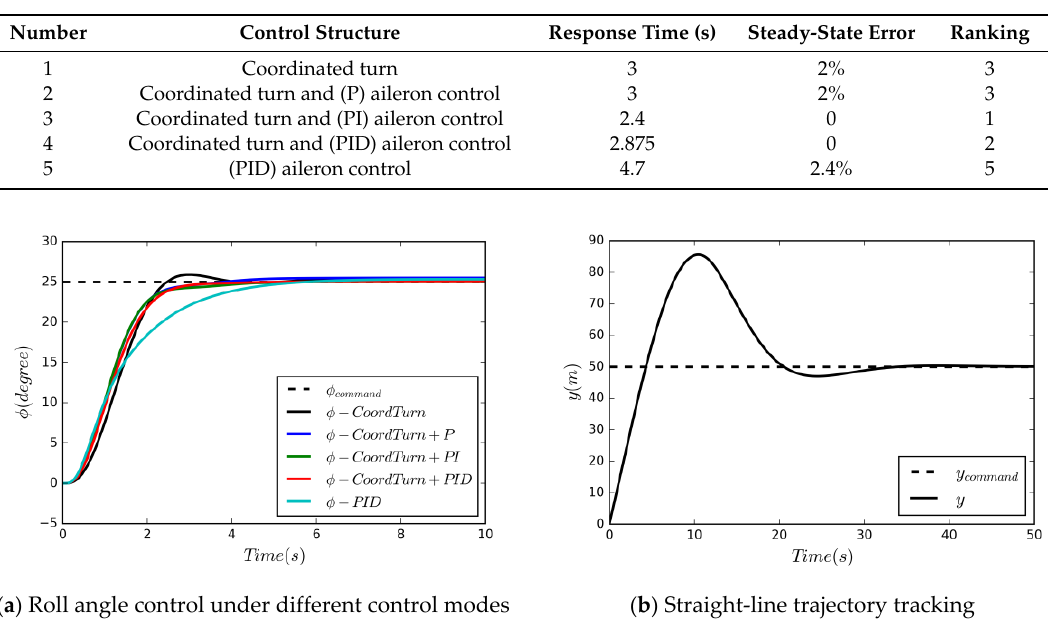
Table 6. Summary of UAV design and performance characteristics.